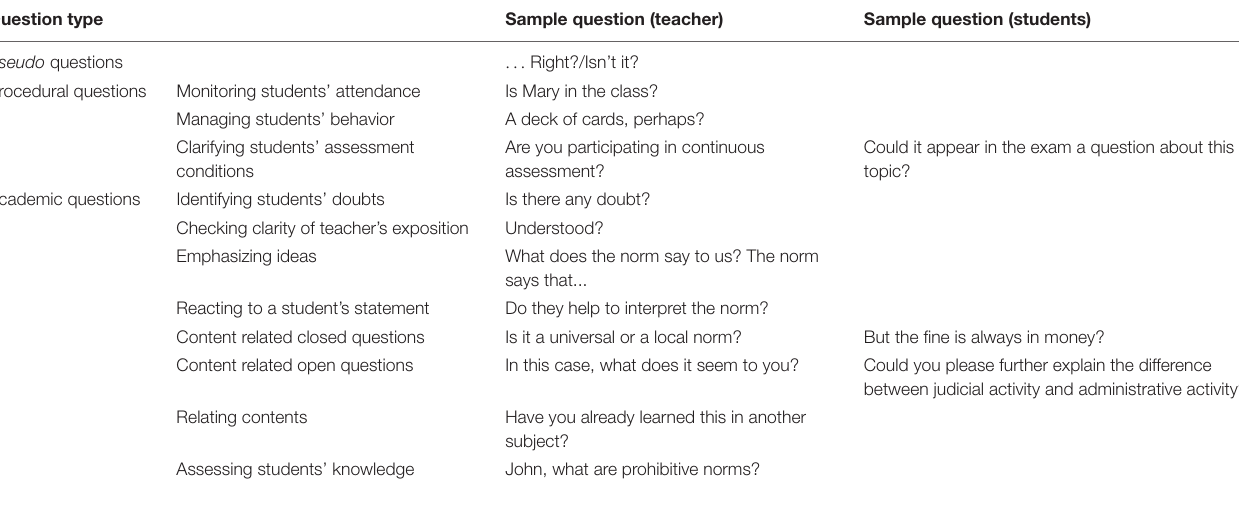
TABLE 1 | Types of questions asked by the teacher and the